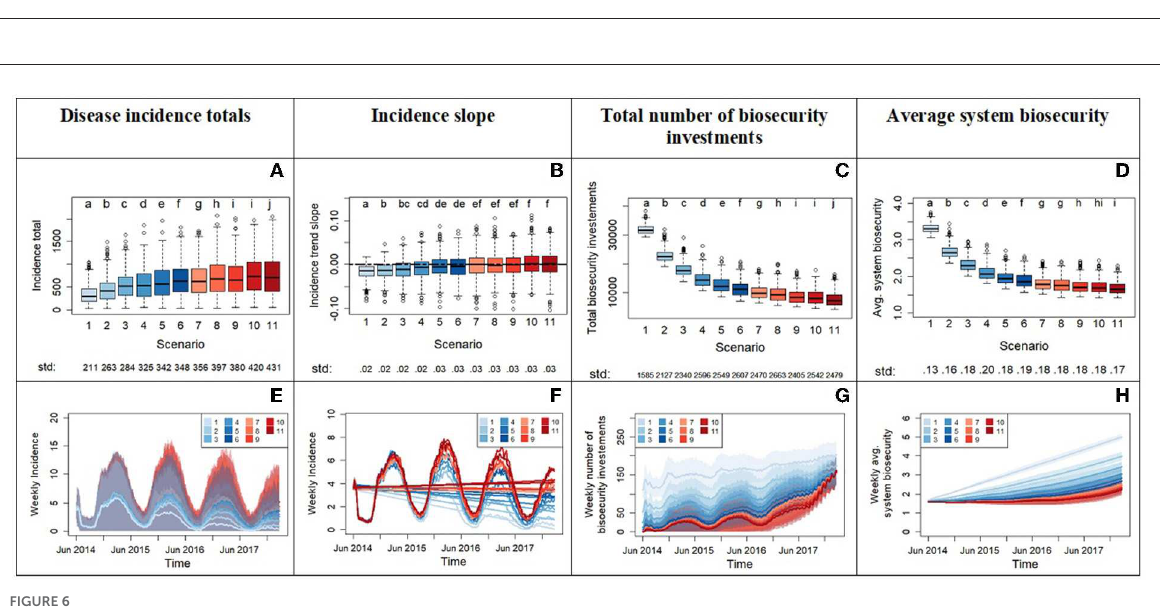
FIGURE5 Outputs from experiment 1 comparing the system with the baseline population (33% averse, 33% opportunist, 33% tolerant) to a system with a more risk tolerant population (0% averse, 50% opportunist, 50% tolerant). The top row displays the box plots of system variables with the x axis showing the scenarios and the y axis reporting values for disease incidence totals (A) , incidence slope from time series (B) , total number of biosecurity investments (C) and average system biosecurity (D) . Letters on top of box plots report results from pairwise distribution comparisons of baseline against the tolerant scenario. Distribution not sharing any letter are different by the two-sample Kolmogorov-Smirnov test at the 5% level of significance. The standard deviation value of each distribution is printed below the box-plot x axis. The bottom row of the figure (E–H) displays the time series with weekly frequency for the variables; the colored shades show the variability provided by the Monte Carlo replicates. Panel (F) zooms into the average weekly incidence lines of panel (E) and includes the linear trends.